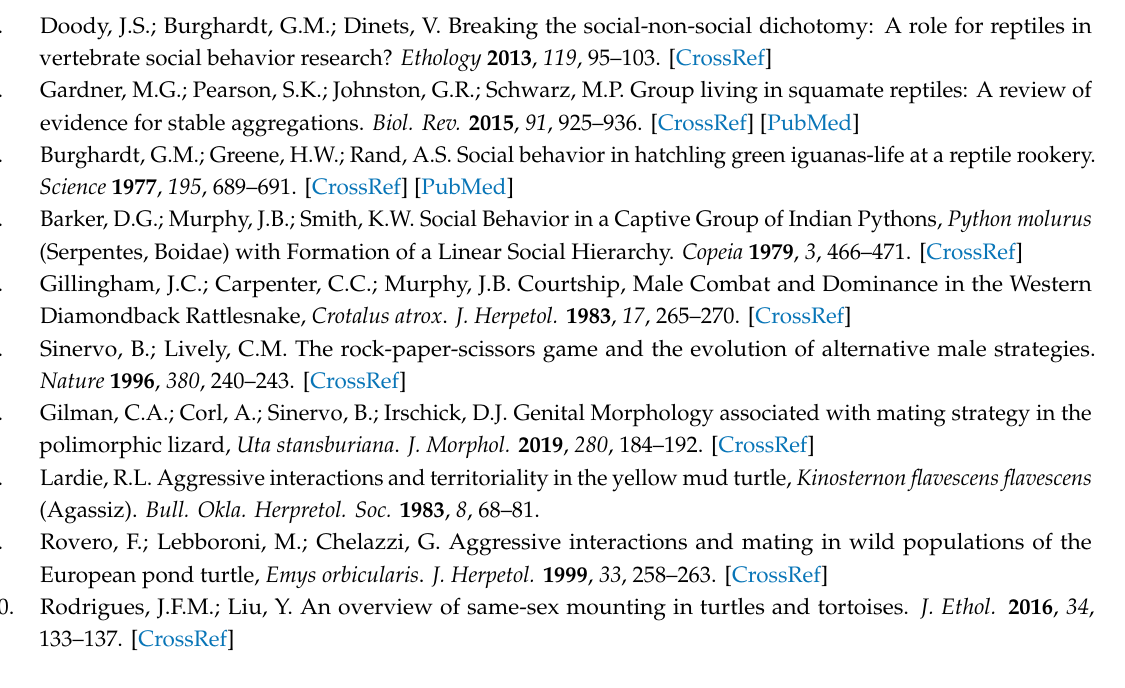
Table S1: Linear mixed models of the di ff erence in Elo-score on the di ff erence in SCL at the end of each